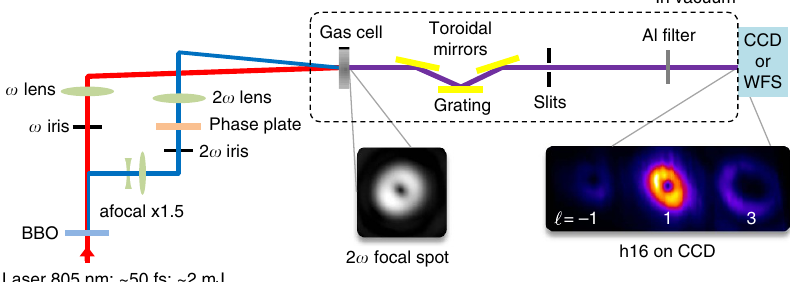
Figure 1 | Sketch of the experimental setup. The collimated laser beam (8mm at 1/ e 2 ) goes through a BBO crystal before entering a dichroic Mach-Zehnder interferometer in which the beam at 805nm can be manipulated independently from the one generated after frequency doubling. The spiral phase plate converts the Gaussian beam into a Laguerre-Gaussian mode with c 2 o ¼ 1 in the second harmonic (2 o ) arm of the interferometer, while the fundamental ( o ) beam remains Gaussian. The mirrors and the delay line used to synchronize the two beams are not drawn, nor the half wave plate used to get identical linear polarizations. Both beams are focused with lenses of 75cm focal length into the generation gas cell ( C 1mm length) filled with argon at a pressure of a few tens of mbar. To optimize the focusing geometry, both lenses are placed on translation stages, irises are positioned in both arms and a beam expander ( (cid:3) 1.5) is used in the 2 o arm. The XUVemission is sent into a monochromator (made of a grating between two toroidal mirrors and slits) before being imaged on an XUV CCD camera or a Hartmann wavefront sensor (WFS) placed in the far-field, C 1m downstream. (Insets) Typical intensity distributions at focus of the 2 o beam (left) and HHG vortices (right, labelled by their topological charge c ) generated at the 16th order and imaged on the